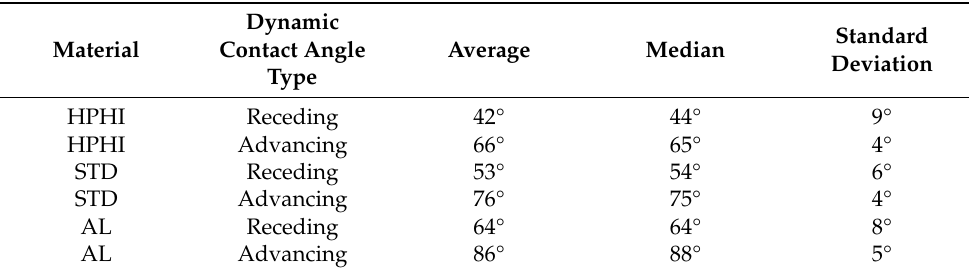
Table 2. Summary of the results of the dynamic contact angle analysis obtained from sessile drops deposed on vertical